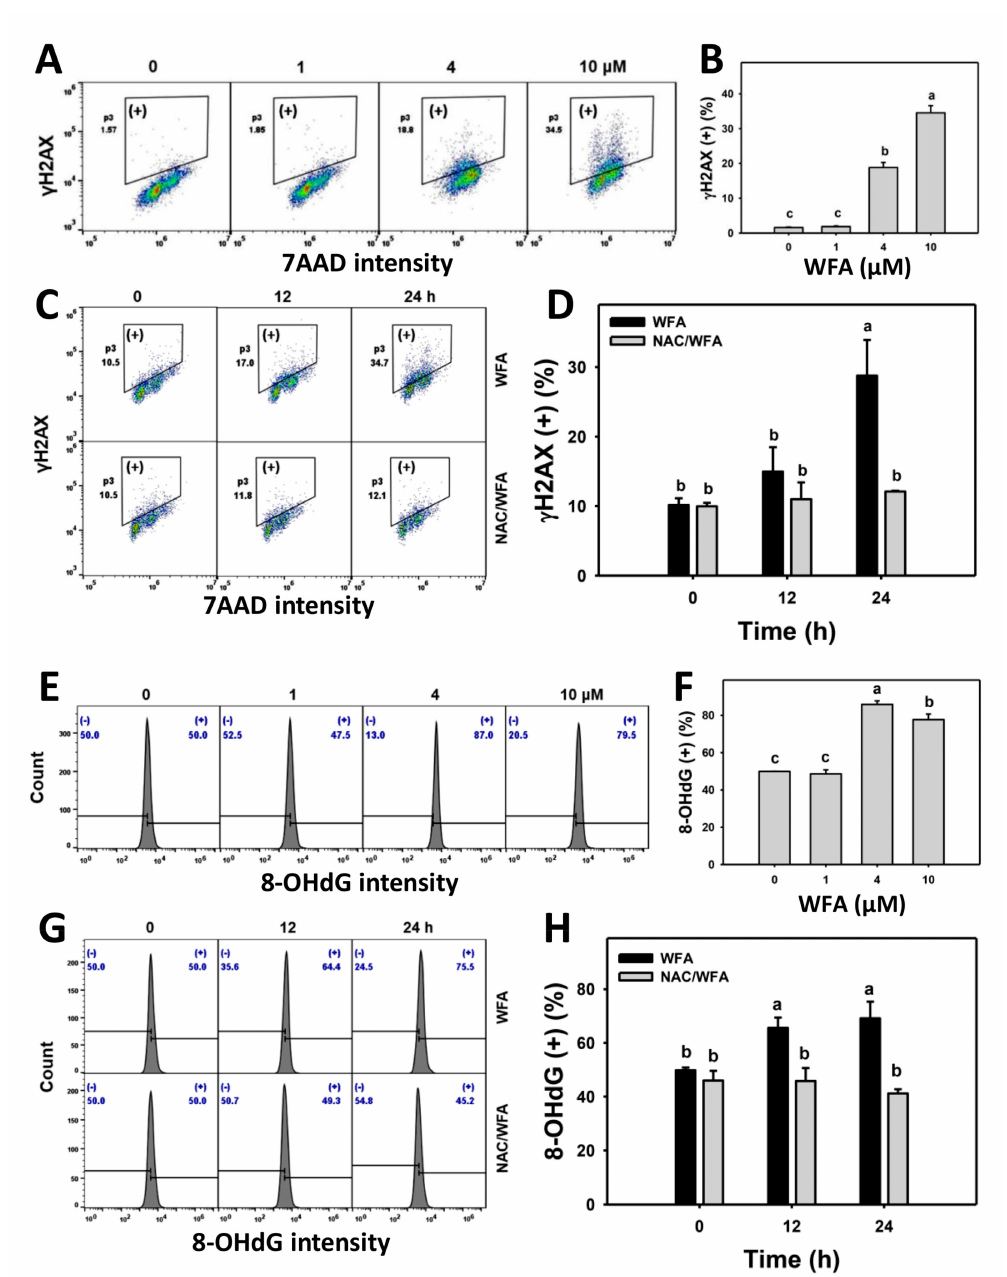
Figure 8. WFA induces DNA damage in bladder cancer cells. ( A , B , E , F ) Patterns and statistics for γ H2AX and 8-OHdG changes. Bladder cancer cells (J82) were treated with WFA (24 h, 0 to 10 µ M), where the negative control for WFA (0 µ M) contained 0.1% DMSO. Symbol (+) indicates γ H2AX or 8-OHdG (+). ( C , D , G , H ) Pattern and statistics for the NAC pretreated effect on the γ H2AX and 8-OHdG expression of J82 cells following WFA incubation. Cells were pretreated and post treated with NAC (8 mM, 1 h) and WFA (0 and 10 µ M for 12 and 24 h), respectively. Data, mean ± SD ( n = 3). Columns showing non-overlapping lower-case letters indicate p < 0.05 for multiple